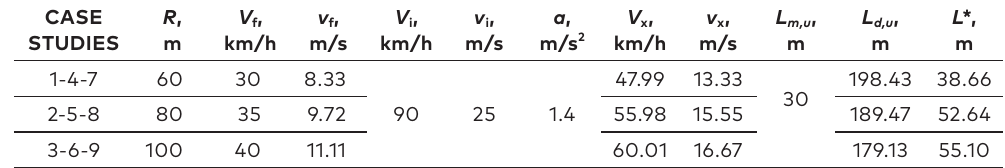
Table 8. Summary of design data and